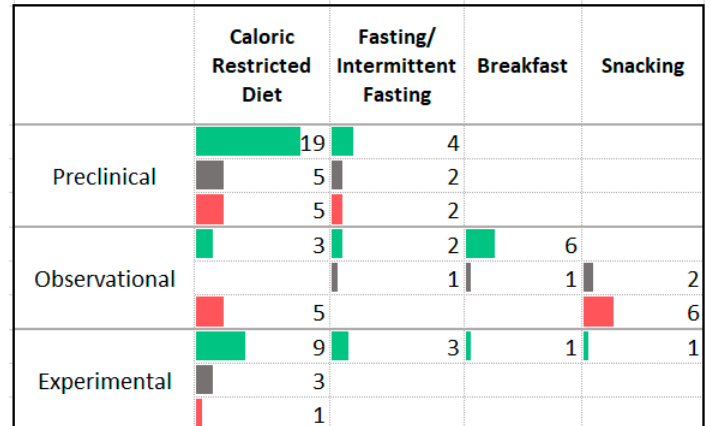
Figure 6. Studies assessing the amount of food consumed or timing of eating. (cid:110) Higher intake or levels associated with decreased anxiety. (cid:110) No association between intake or levels and anxiety. (cid:110) Higher intake or levels associated with increased